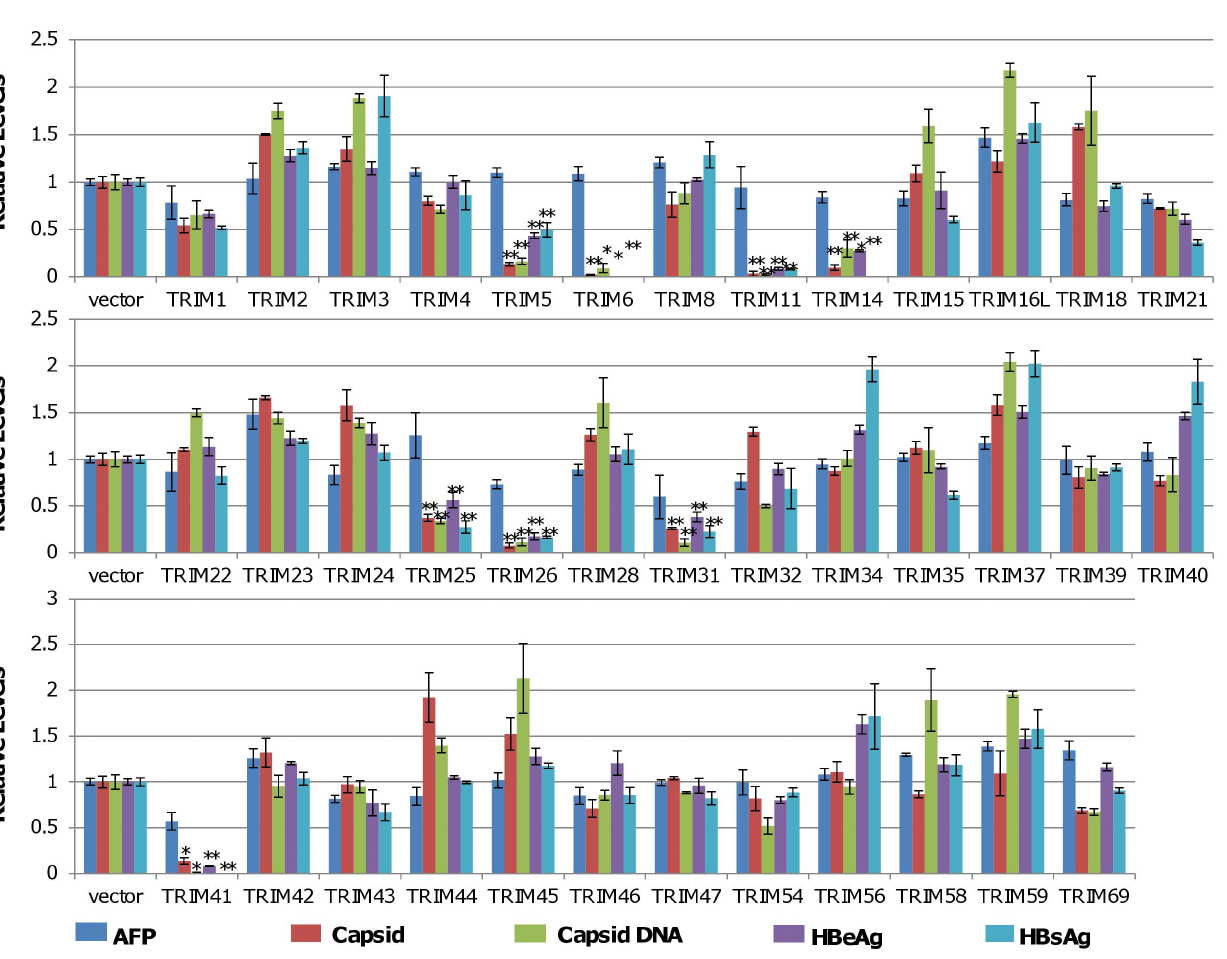
Figure 1. Identification of TRIMs that regulate HBV viral protein expression, capsid assembly and DNA replication. HepG2 cells in 12 well plates were co-transfected with 0.4 m g of pHBV1.3 and 0.4 m g of plasmid expressing an indicated TRIM protein or a control vector. 72 hours after transfection, the levels of the secreted HBeAg and HBsAg were determined by ELISA. The amounts of intracellular capsid and capsid DNA were determined by a viral particle gel assay. The levels of AFP in cultured media were determined by ELISA and served as a cellular function and viability control. The levels of HBeAg, HBsAg, capsid, capsid DNA and AFP from the samples co-transfected with pHBV1.3 and an indicated TRIM-expressing plasmid were expressed as a ratio over that obtained from samples co-transfected with pHBV1.3 and vector plasmids. The mean and standard deviations (n=3) were presented. * and ** indicate P , 0.05 and 0.01, respectively.